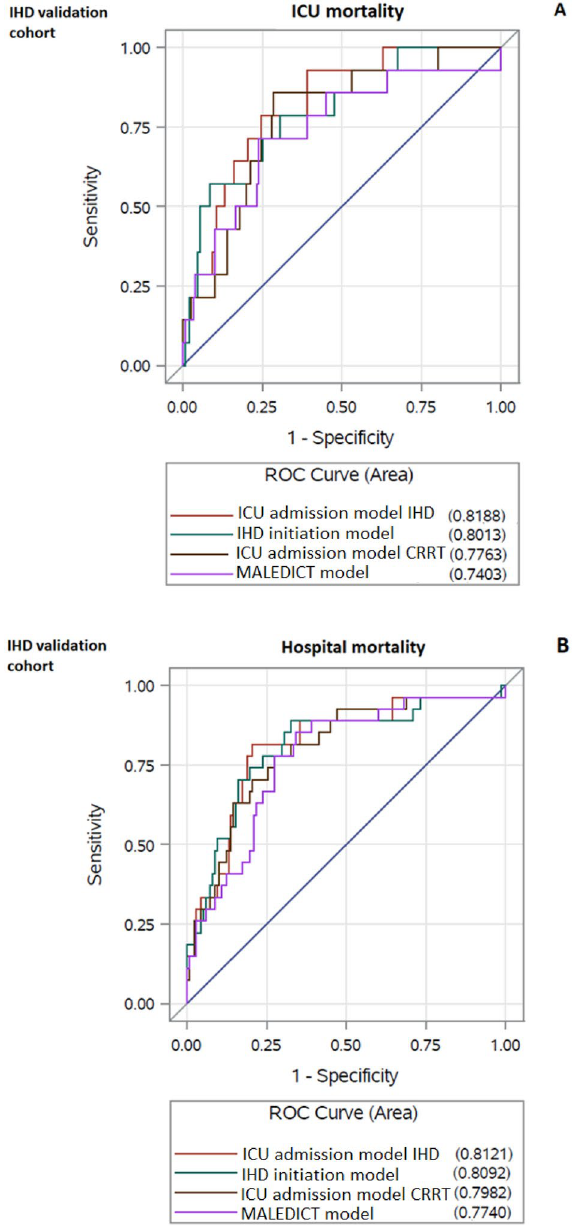
Figure 3. Receiver operating characteristics (ROC) curves for the final multivariable models for ICU and hospital mortality in the intermittent hemodialysis (IHD) validation cohort. ( A ) The best ICU admission and RRT initiation models for ICU mortality in IHD patients and the CRRT ICU admission and CRRT RRT initiation (MALEDICT) models in the IHD validation cohort; ( B ) the best ICU admission and RRT initiation models for hospital mortality in IHD patients and the CRRT ICU admission and CRRT RRT initiation (MALEDICT) models in the IHD validation